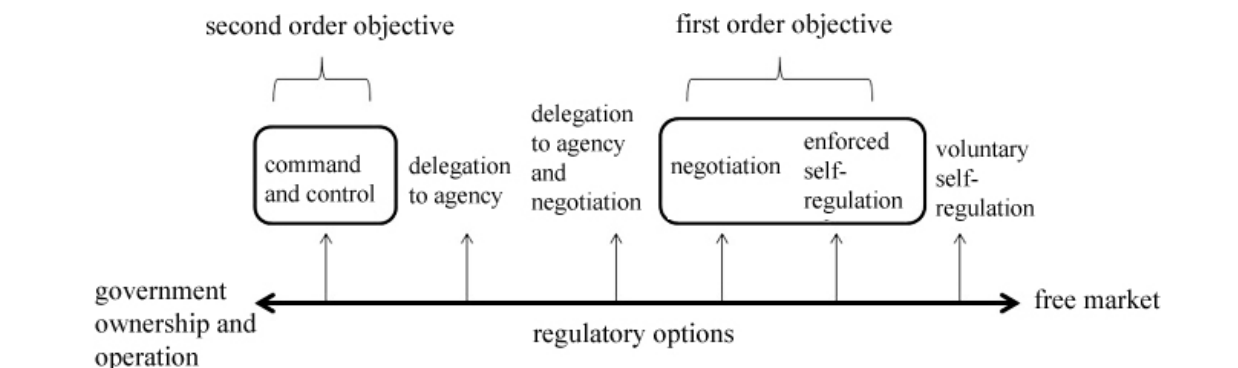
Fig. 1 . Critical infrastructure regulation for climate change adaptation in